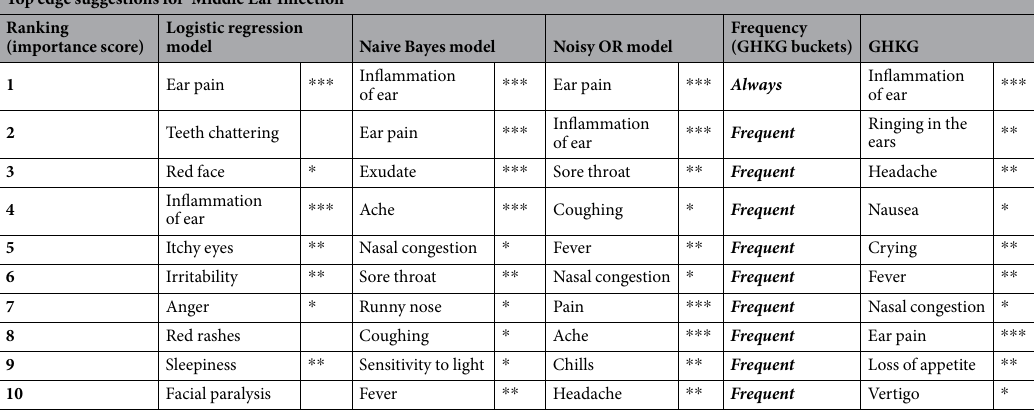
Table 1. Top edge suggestions by models for a randomly chosen disease (Middle Ear Infection). The number of shown edges corresponds to the number of edges in the GHKG. For logistic regression, naive Bayes, and noisy OR the suggestions are ordered by their relative importance score. For the GHKG, the edges are sorted according to two broad buckets of edge frequency that are provided in the graph. The stars associated with each edge represent the expected frequency for which “disease A causes symptom B” as rated by physicians.